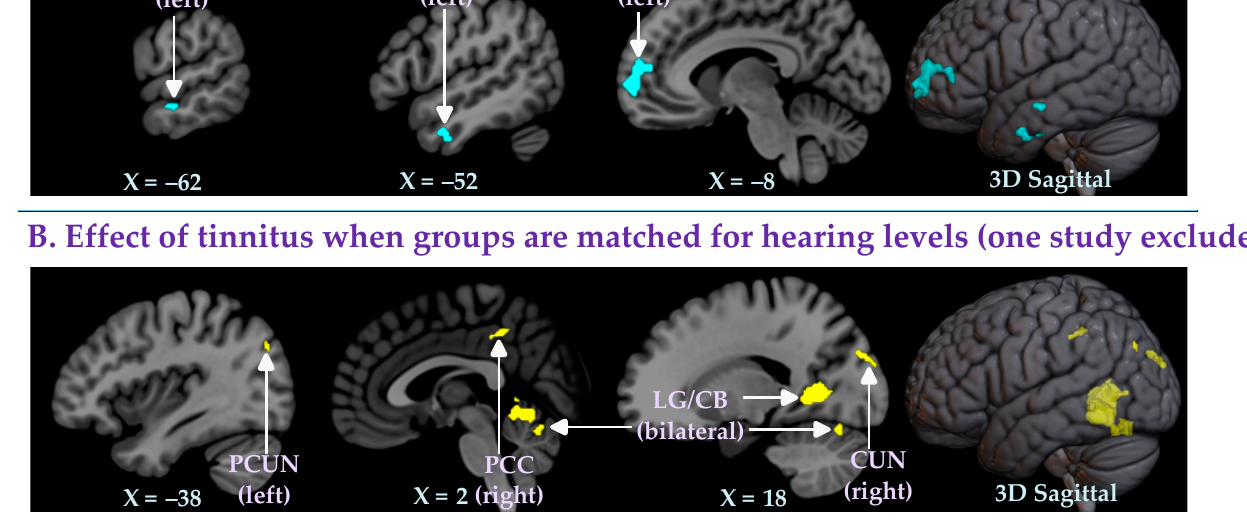
Figure 2. Whole-brain meta-analyses of studies comparing individuals with and without tinnitus, ( A ) including all studies and ( B ) excluding one study [31] that did not match groups for hearing levels, using TFCE FWE-corrected statistics ( p ≤ 0.05, cluster size k ≥ 10 voxels). ( A ) Lower gray matter levels in the left anterior cingulate cortex (with a cluster extending to the medial prefrontal cortex), the left inferior temporal gyrus, and the left middle temporal gyrus in the groups with tinnitus (NH+T and HL+T) compared to the groups without tinnitus (NH − T and HL − T), regardless of whether or not the groups were matched for hearing levels. ( B ) Higher gray matter levels in the right cuneus, the bilateral lingual gyrus (with a cluster extending to the cerebellum), the right posterior cingulate cortex, and the left precuneus in the groups with tinnitus (NH+T and HL+T excluding study [31]) compared to the groups without tinnitus (NH − T and HL − T excluding study [31]) and matched for hearing levels. Note: ACC, anterior cingulate cortex; CB, cerebellum; CUN, cuneus; ITG, inferior temporal gyrus; LG, lingual gyrus; mPFC, medial prefrontal cortex, MTG, middle temporal gyrus; PCC, posterior cingulate cortex; PCUN, precuneus. Table 3. Whole-brain meta-analyses of studies comparing individuals with and without